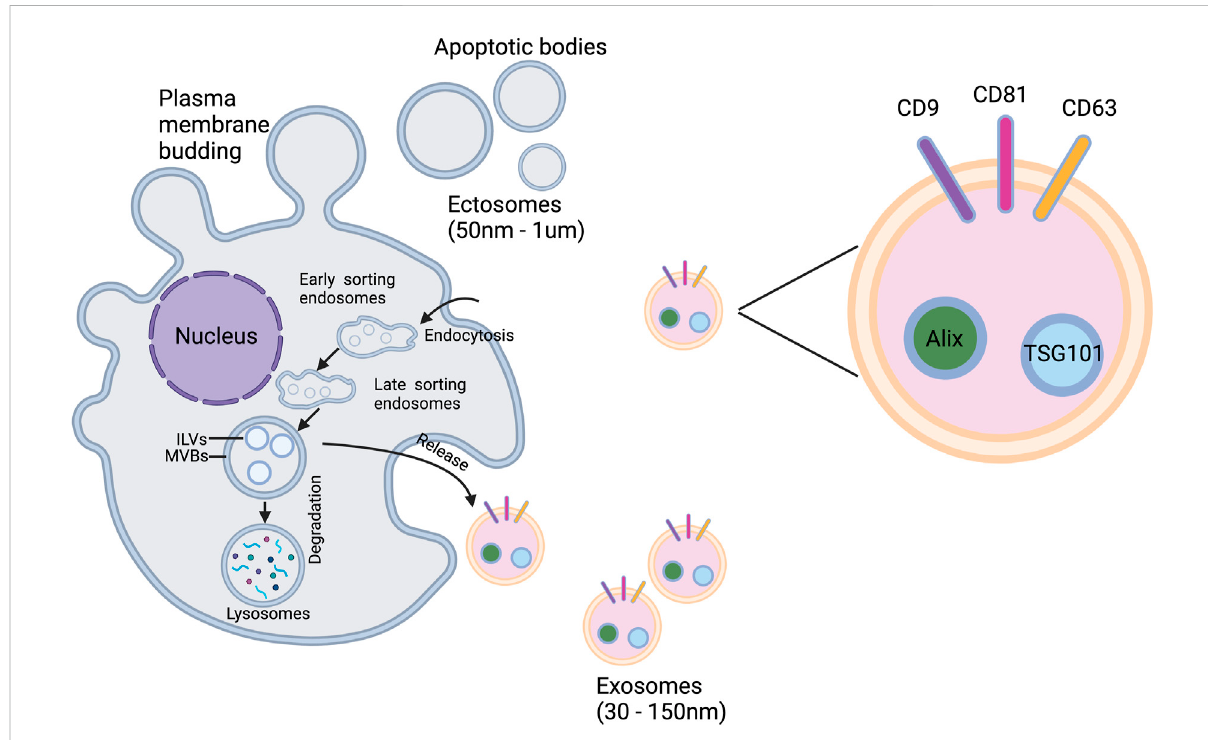
FIGURE 1 Two major types of EVs formation and release